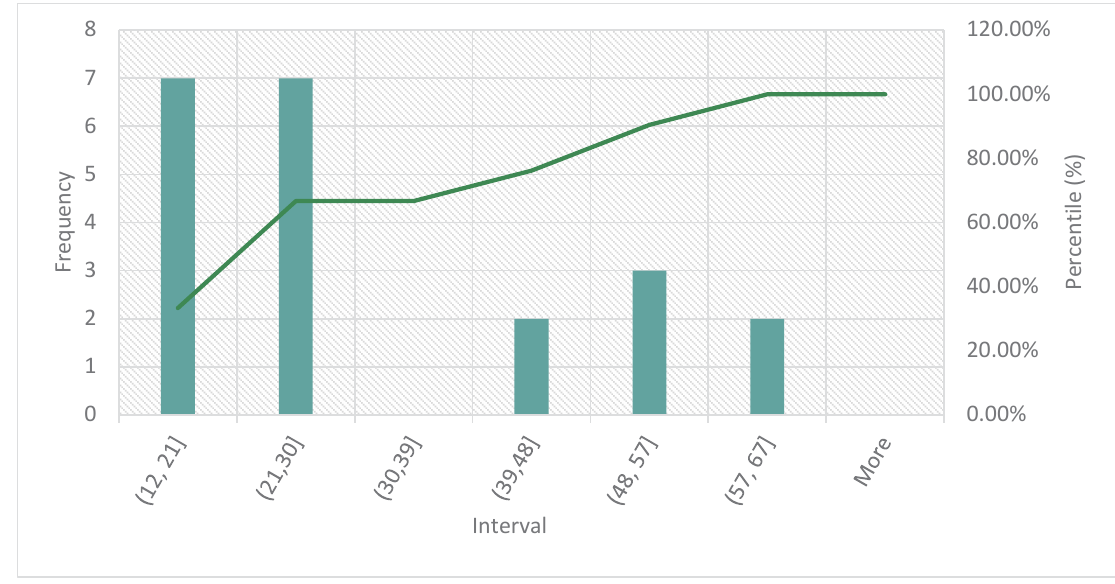
Fig. 7: Histogram and Pareto Graphic for TP in Osceola County